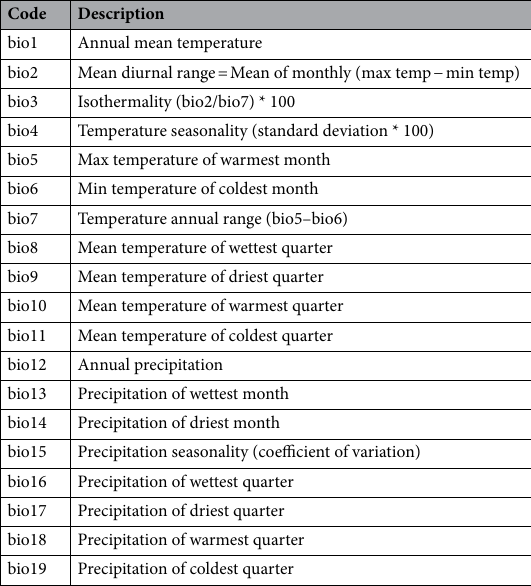
Table 1. Codes of climatic variables developed by Hijmans et al. 41